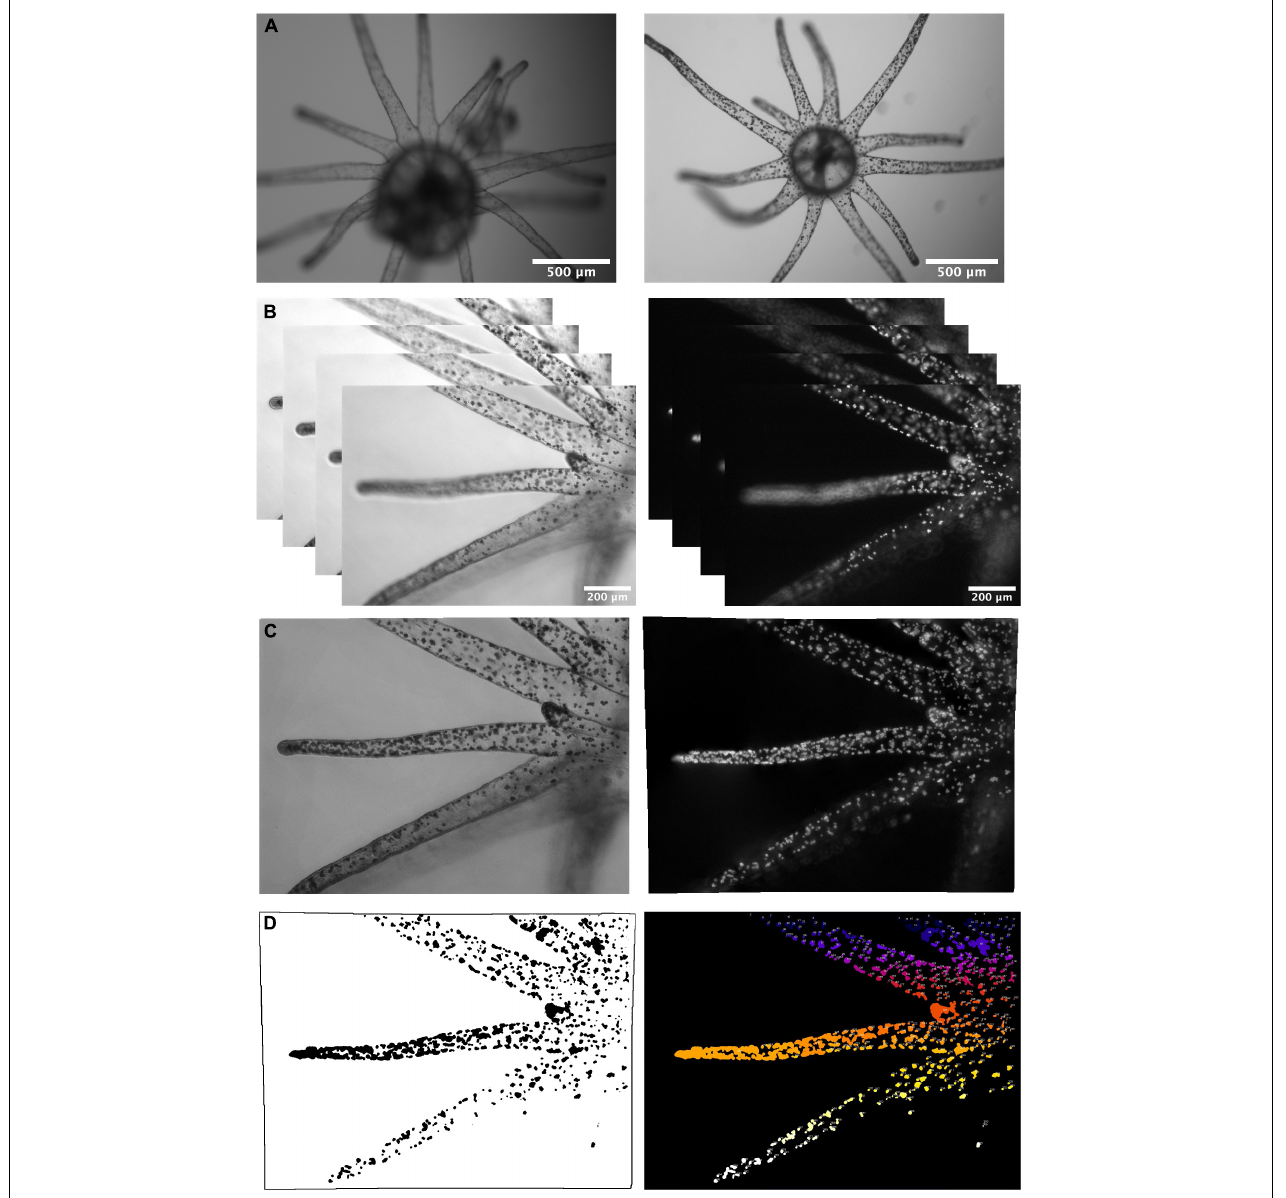
FIGURE 1 | Imaging colonization dynamics in Aiptasia polyps using epifluorescence microscopy. (A) Bleached Aiptasia polyps (left: day 0) were colonized with algal symbionts over a period of 4 weeks (right: day 10) and imaged under brightfield and epifluorescence to track symbiont autofluorescence. (B) Videos were taken as representative Z-stack images under brightfield (left) and laser excitation (right) to provide focus for each z-plane of the tentacles. (C) Videos were merged into 2D images, and (D) the epifluorescence images were processed in Fiji (ImageJ2) to create a 2D mask of symbiont presence (left), which was used to identify size and location of symbiont cluster objects (right). The number of cells within each cluster was determined based on object size cutoffs.